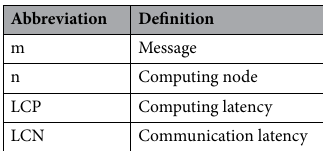
Table 3. Abbreviations used in the